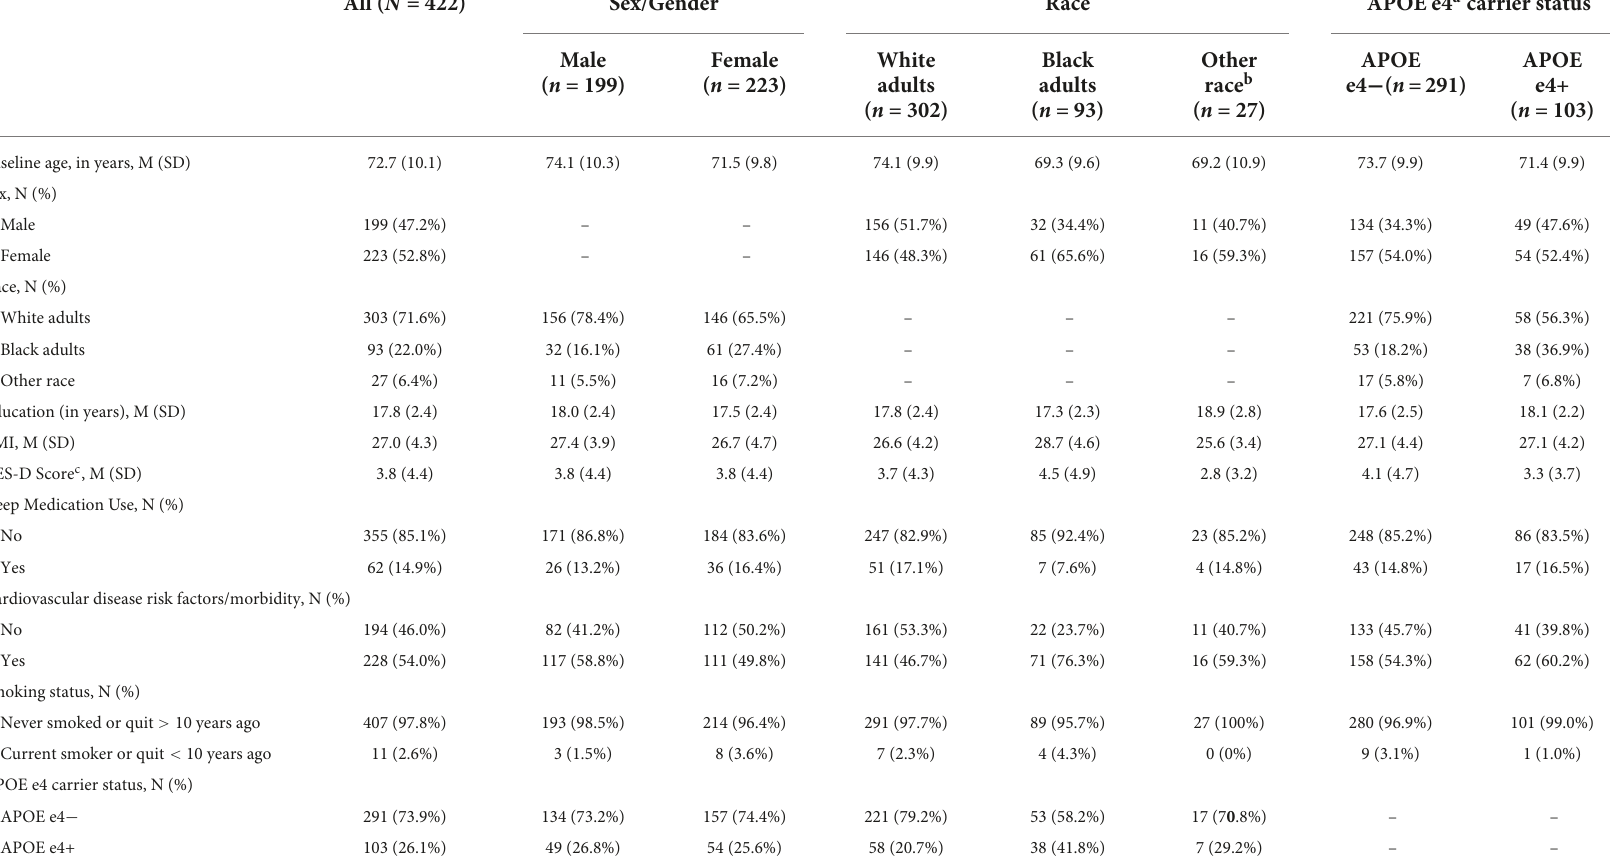
TABLE 3 Baseline participant characteristics for the whole sample and stratified by sex, race, and APOE e4 status. All ( N =